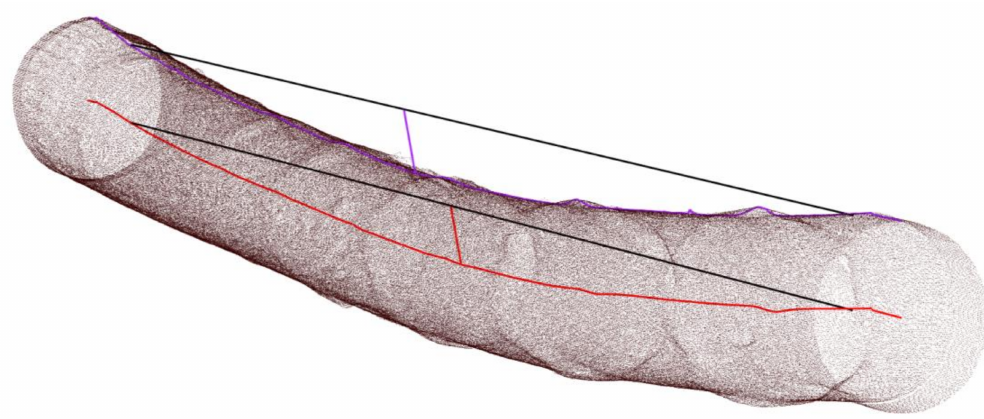
Figure 1. Schematic illustration of the two common approaches for the determination of bow heights (contour approach in purple, centerline approach in red) of a 5.08 m long pine log that was measured as a 360 ◦ -Scan on a Microtec DiShape Laser-System at the Forest Research Institute of Baden-Wuerttemberg. In this illustration, on both sites of the log (butt end and top end), an offset towards the middle of the log is applied for the reference lines (black) to reduce the effect of root run up and defects at the log ends on the curvature